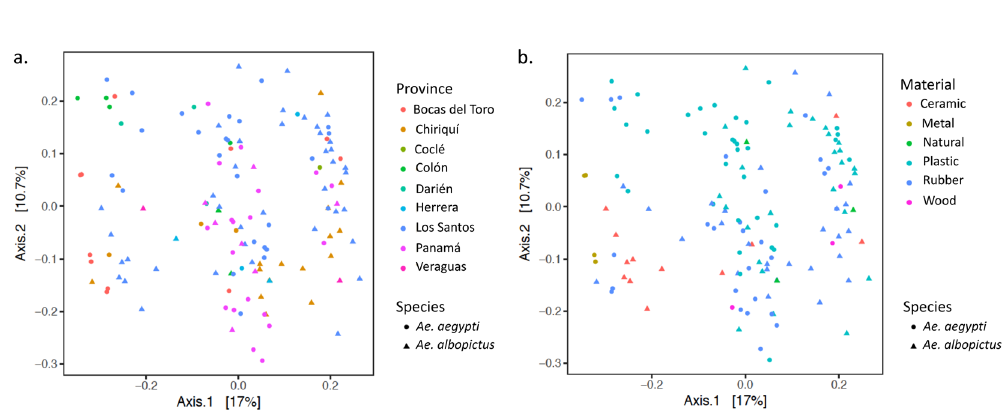
Figure 6. PCoA plots of UNIFRAC distances of the microbial community of Ae . aegypti and Ae . albopictus taken from ( a ) different provinces of Panama and ( b ) oviposition site